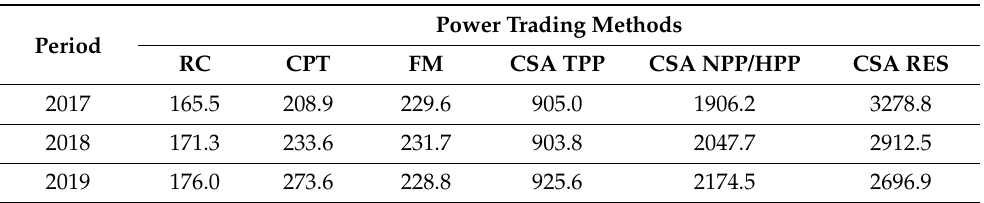
Table 1. Weighted average prices for capacity using various trading methods: first price zone, thousand rubles/MW.